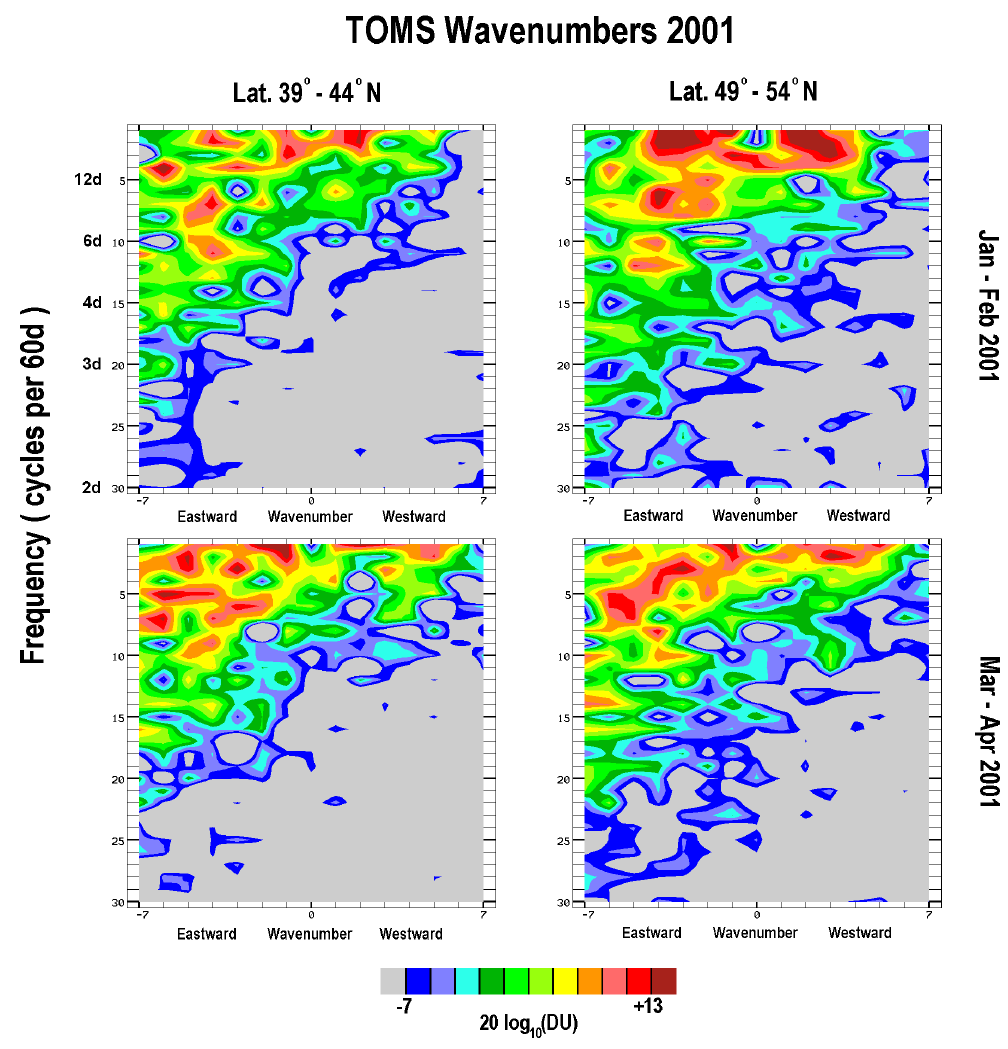
Fig. 7. TOMS wave number spectra for two latitude bands during the days 1–60 of 2001. The full set of available longitudes is used for these